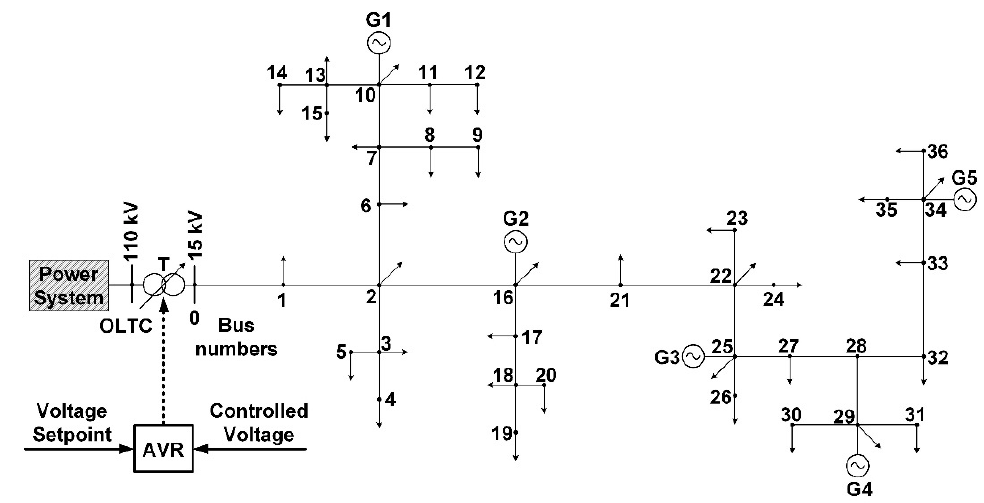
Figure 6. IEEE 37 test network diagram [86]. Table 1. Parameters of the individual sections of the MV line.